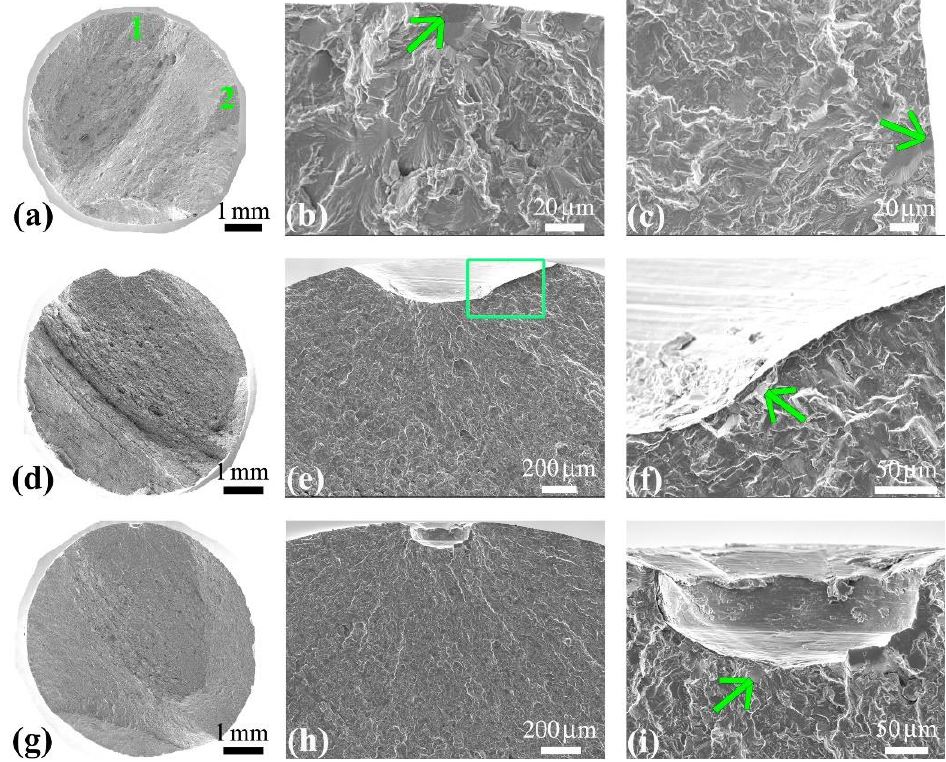
Figure 7. Morphologies of fracture surface of several failed specimens at σ max = 815 MPa under conventional fatigue testing. ( a – c ): Smooth specimen with N f = 10,623 cycles, ( b , c ) are magnified images of crack initiation regions 1 and 2 in ( a ), respectively; ( d – f ): defective specimen with N f = 4621 cycles, ( e , f ) are magnified images of crack initiation region in ( d ) and the rectangular region in ( e ), respectively; ( g – i ) defective specimen with N f = 6961 cycles, ( h , i ) are magnified images of crack initiation regions in ( g , h ), respectively. The arrows point to the small regions exhibiting facet